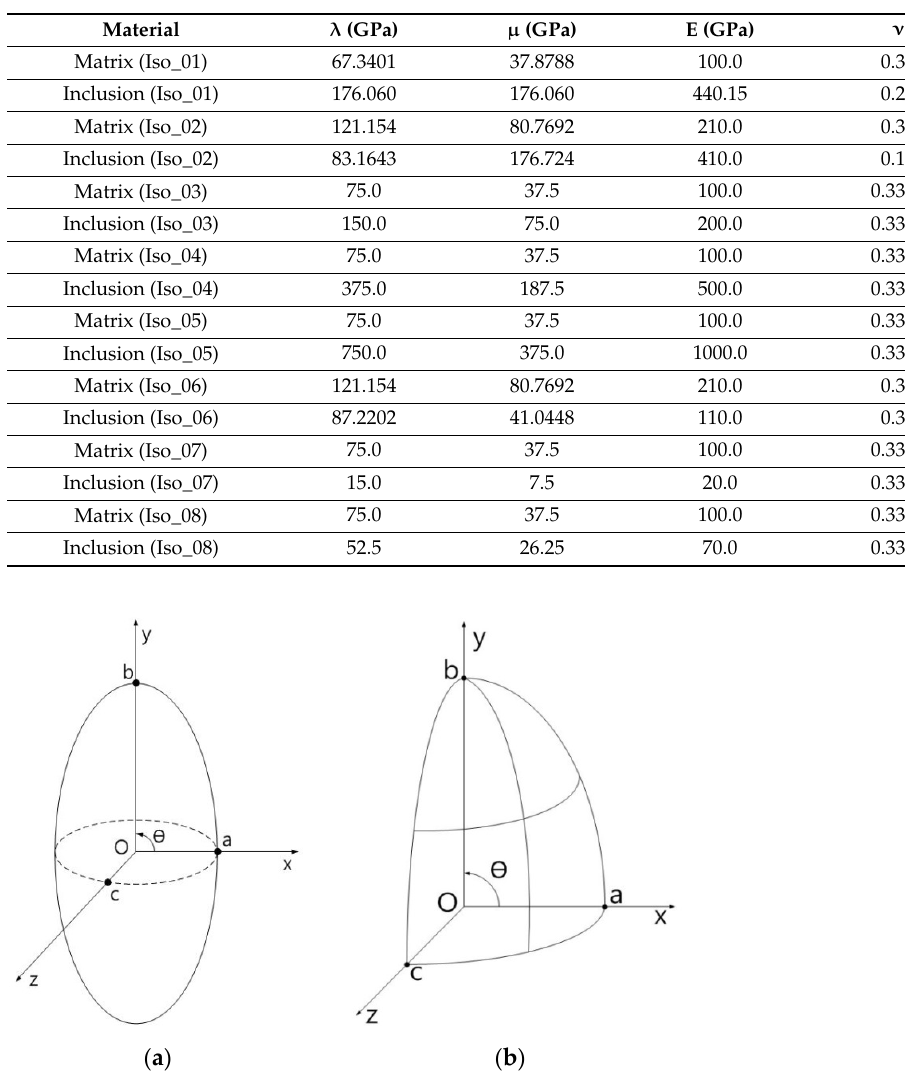
Figure 5. The orientation of spherical, prolate spheroidal and oblate spheroidal inclusions. ( a ) Spheroidal coordinate system. ( b ) Cartesian coordinate system. The elastic constants for the isotropic matrix and the isotropic inclusions are listed in Table 2. The elastic constants for the isotropic matrix and the orthotropic inclusions are listed in Table 3. Table 2. Material Properties of the Isotropic Matrix and the Isotropic Inclusions. Material